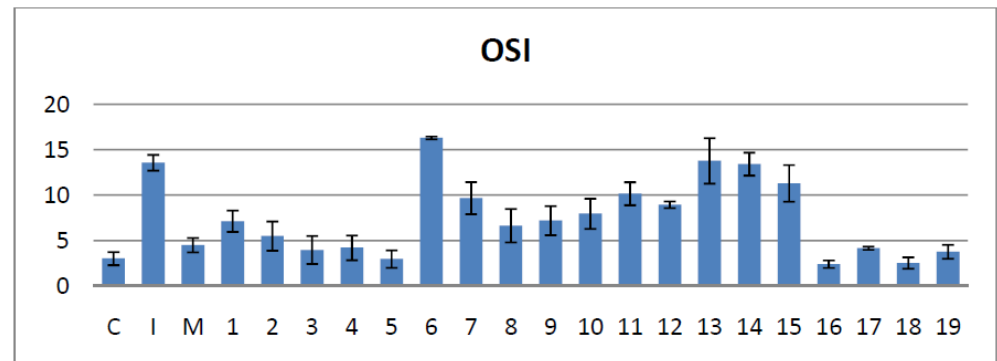
OSI = oxidative stress index, C = negative control; I = inflammation; M =